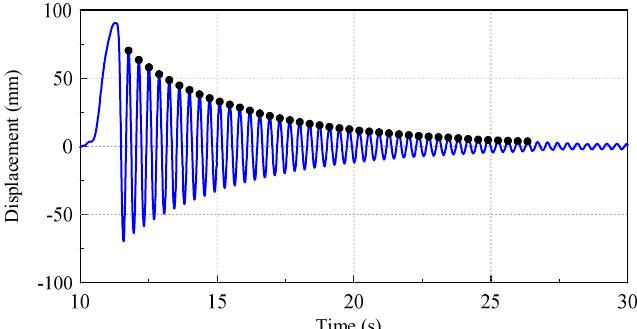
Figure 6. The dynamic displacement decay history of free vibration of a scaled model OWT.